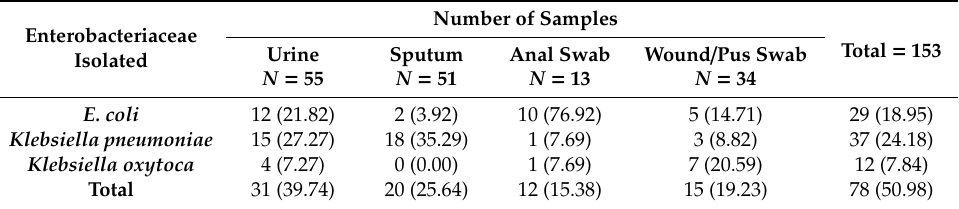
Table 2. Percentage (%) Prevalence of Isolates in the samples. Table 3. Carbapenem susceptibility of isolates.